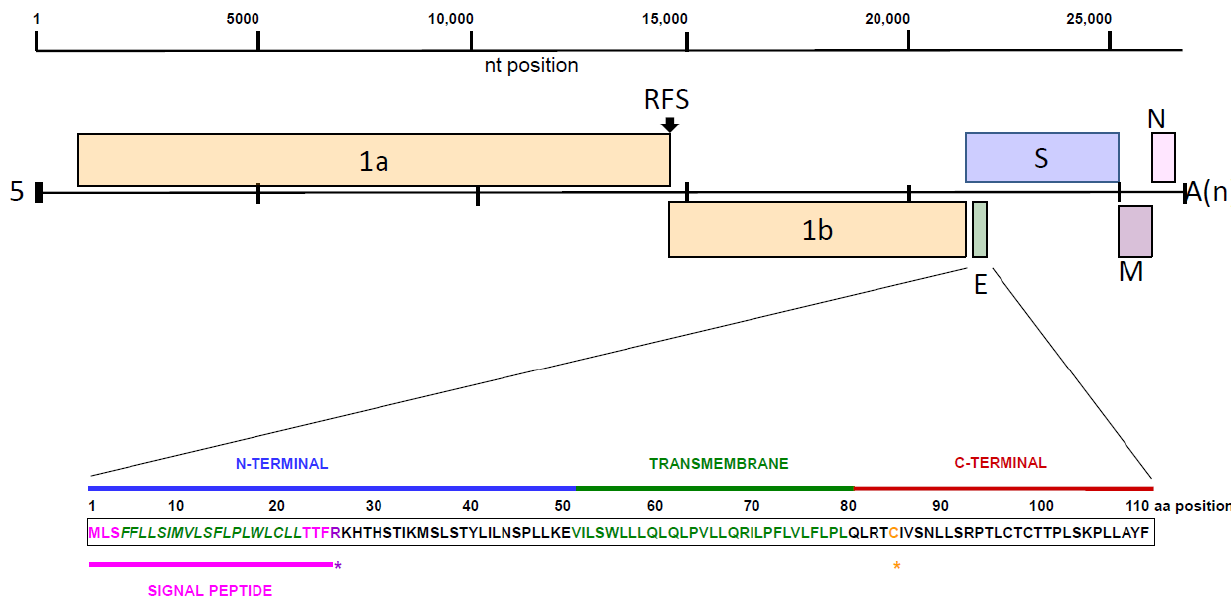
Figure 1. The genome architecture of ASBV VT01292015-09 with canonical features of nidovirus genomes annotated. The full-length RNA genome is 26,496 nucleotides. Boxes represent major open reading frames (ORFs). The proteins encoded by the ORFs are also indicated within, above, or below the boxes. The arrow indicates the position of the putative ribosomal frameshift (RFS) “slippery” sequence (putative replicase polyprotein 1a and 1b; putative envelope protein E (p12.7); S, spike protein; M, membrane protein; and N, nucleocapsid). The 5 (cid:48) capped mRNA with a leader sequence is depicted by a small black box. The poly(A) tail is indicated by A(n). The predicted structure of the ASBV E protein consisting of three domains: the amino-terminal (N-terminal at aa positions 1–50), the putative transmembrane α -helical hydrophobic domain (at aa positions 51–79), and the carboxy-terminal (C-terminal at positions 80–110) is shown. The ASBV E protein is predicted to be a Type I membrane protein with an N-terminal cleaved signal sequence. The residues in the two hydrophobic domains are in green, one in italics (aa positions 4–22) is in the signal peptide region (pink at aa positions 1–25), and another in the transmembrane domain (green at aa positions 51–79), which would impose a hairpin topology for the ASBV E protein before the N-terminal signal peptide is cleaved off. A signal peptidase cleavage site is marked with a star (*) at residue R26 in purple (proposed to be in the ER lumen/virion exterior resulting in a Type I membrane protein (i.e., a mature protein with N-terminus on the ER lumen/virion exterior and the C-terminus exposed to the cytoplasmic side/virion interior). The predicted palmitoylation site at residue C84 is marked with a star (*) in